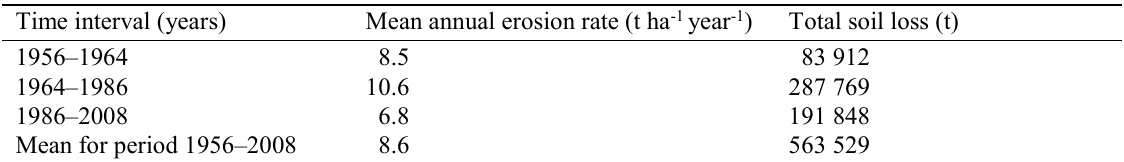
Table 1 Mean annual erosion rates and total soil losses from cultivated slopes in the Lebedin catchment for three time intervals covering the period after dam construction at the catchment outlet. Time interval